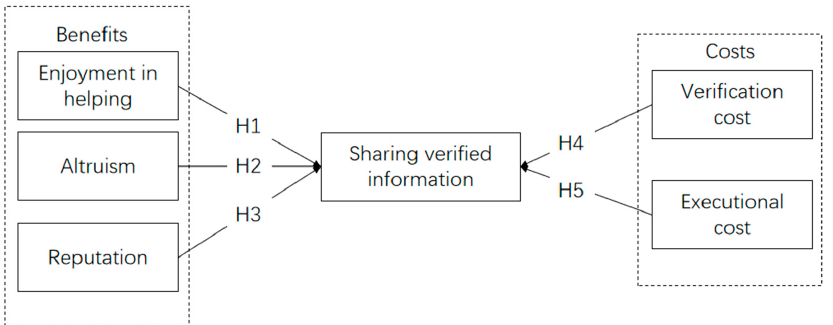
Figure 1. Research model and hypothesized relationships.